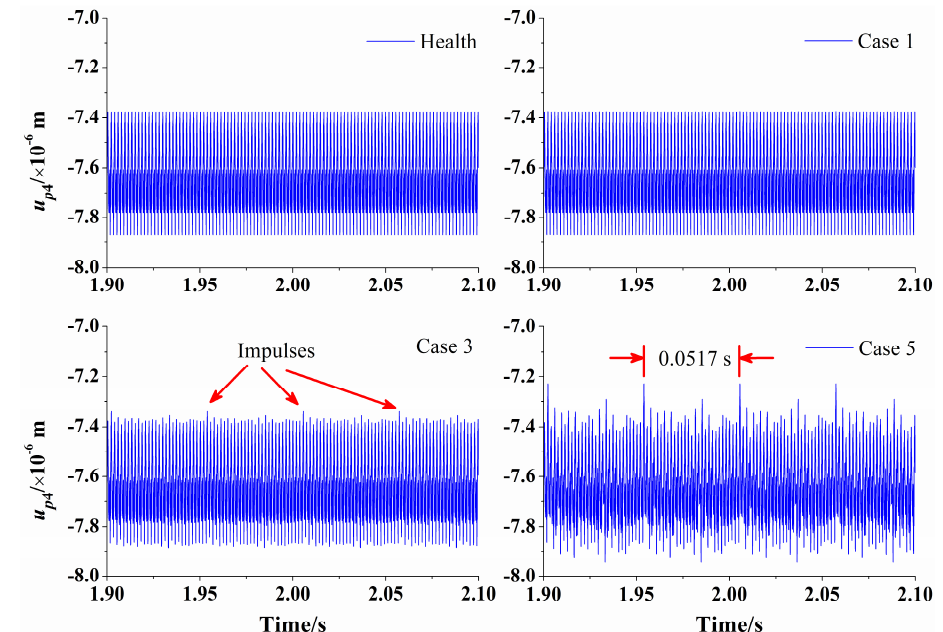
Figure 18. Time histories of torsional vibration responses on the 4th planet gear.